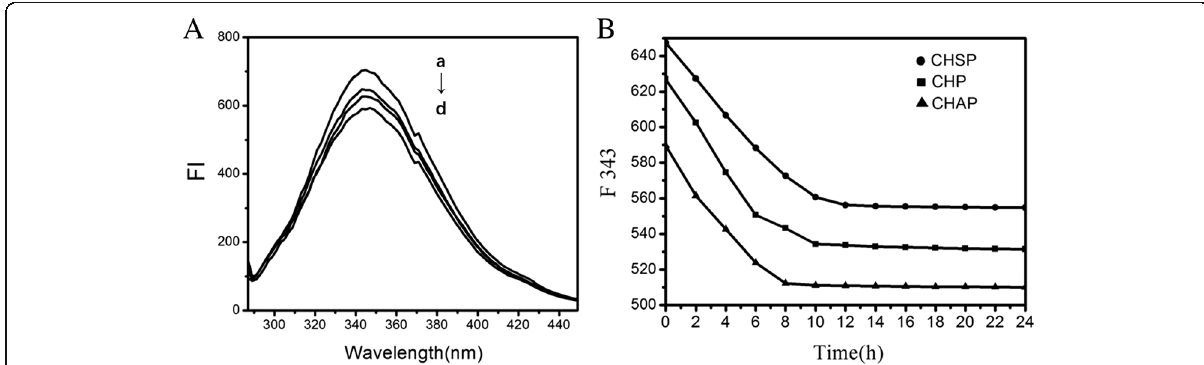
Fig. 6 A Fluorescence spectra for HSA (1.5 × 10 − 5 mol/L) without (a) and with (b) CHSP, (c) CHP and (d) CHAP NPs with the same concentration (4.2 × 10 − 6 mol/L). B HSA emission intensity with CHSP, CHP, and CHAP NPs at 343 nm over